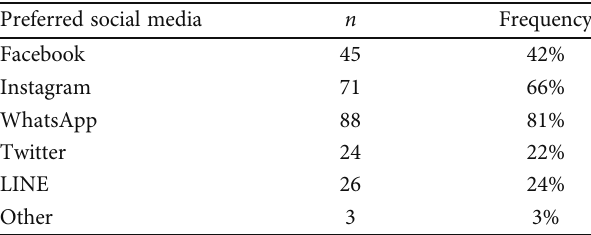
Table 3: Descriptive results of social media usage.